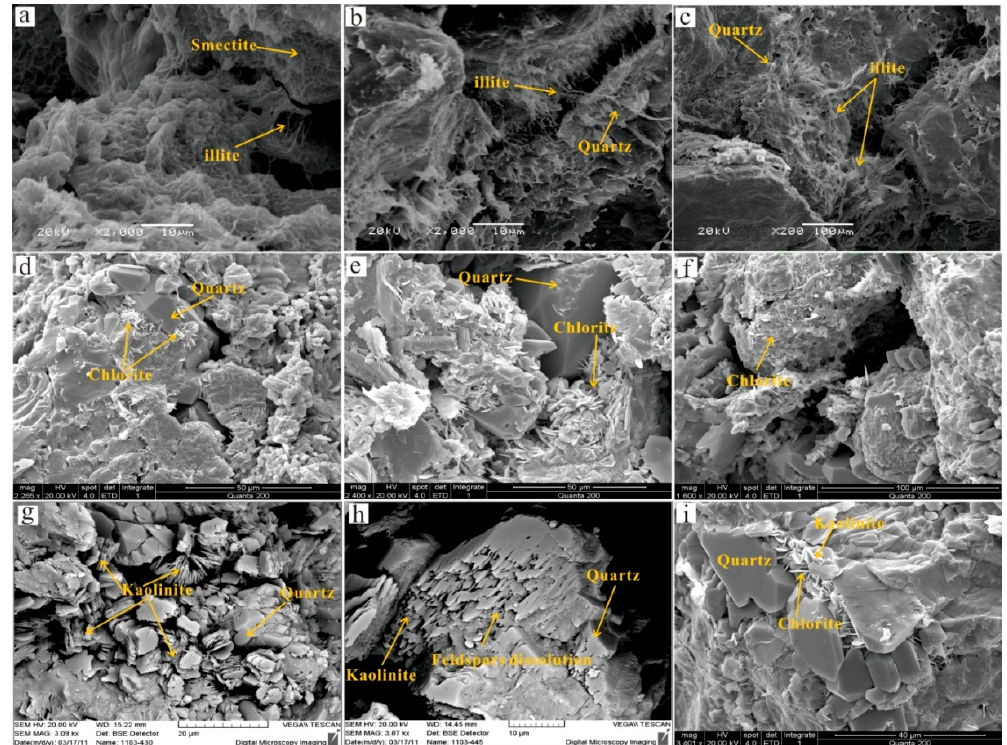
Figure 11. Scanning electron micrographs of sandstones showing characteristics of clay cements. ( a ) Pore filling illite and smectite. ( b ) Fibrous morphology of illite typically appears as fibrous aggregates that bridge and filling in pores. ( c ) Irregular flakes with lath-like illite usually attach to the quartz overgrowth. ( d ) The pore-lining chlorite occurs locally as irregular needle crystals perpendicular and parallel to the quartz grain surfaces. ( e ) Pore-filling aggregate chlorite minerals consist of rosette-shaped platelets oriented radially and occluding the intergranular pores. ( f ) Platelets of authigenic chlorite seem to inhibit quartz overgrowth. ( g ) Kaolinite occurs primarily as stacks of booklets aggregates. ( h ) Kaolinite is commonly associated with feldspar grain dissolution and silica precipitation. ( i ) Platelets of kaolinite that retards the growth of chlorite.